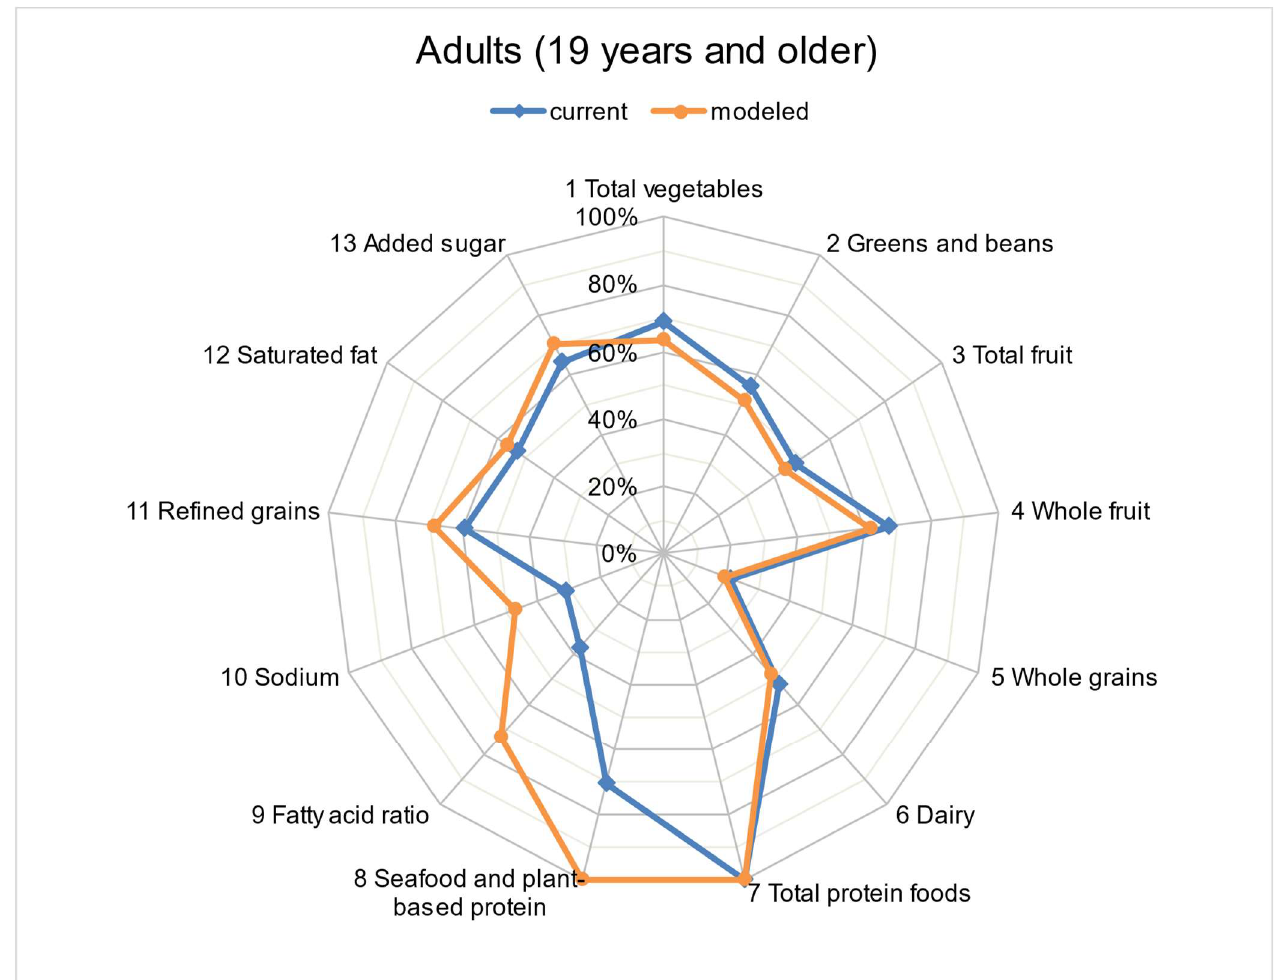
Figure 3. Radar plot to compare HEI-2015 * component scores (% of maximum possible score) for current intake and modeled intake (addition of 1 ounce of walnuts) among adults aged >19 years. * HEI-2015 includes 13 dietary components. Nine adequacy components (those recommended for inclusion in a healthy diet) include total vegetables (5), greens and beans (5), total fruits (5), whole fruits (5), whole grains (10), dairy (10), total protein foods (5), seafood and plant proteins (5), and fatty acids ratio (10). Four moderation components (those that should be consumed sparingly) include sodium (10), refined grains (10), saturated fats (10), and added sugars (10) (21).